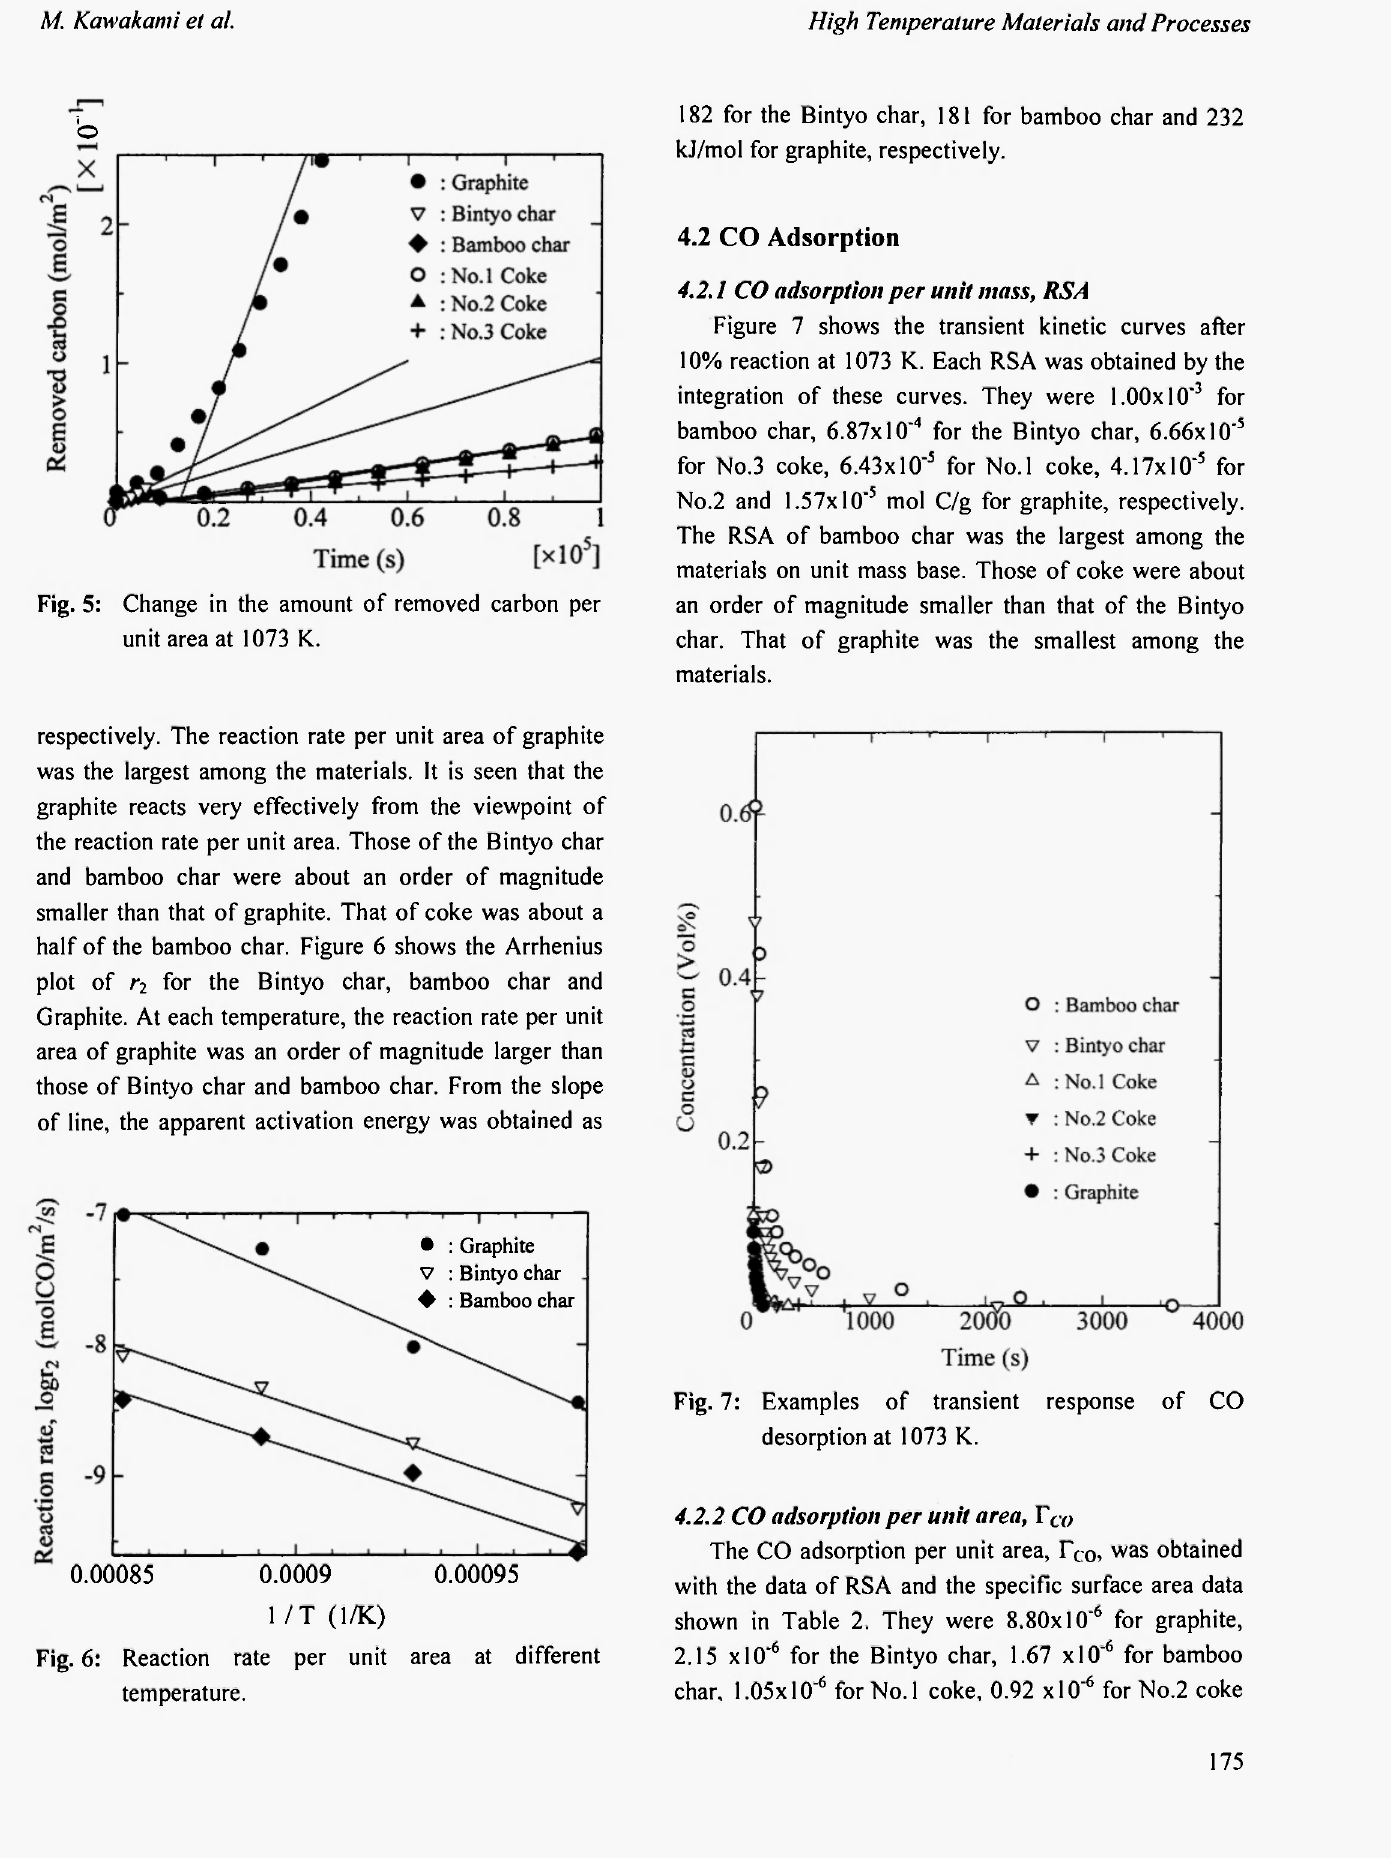
Fig. 6: Reaction rate per unit area at different